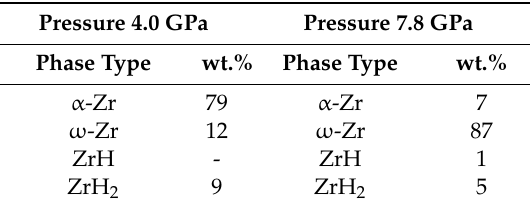
Figure 8. The X-ray di ff ractograms for sintered Zr 2 powders (98.8% purity), under pressures of 4.0 GPa and 7.8 GPa, sintered at 1473 K. Table 4. The qualitative and quantitative composition data of sintered Zr 2 powder (sintering conditions: T = 1473 K, t = 1 min) .